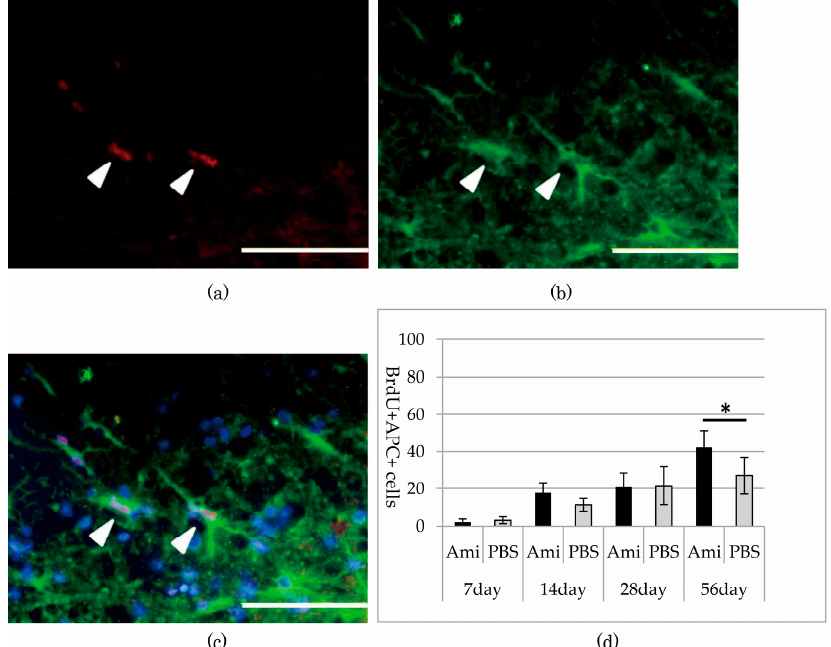
Figure 4. ( a – c ) Double immunostaining of the dorsal funiculus from the amiloride group at day 56 for BrdU (red) and adenomatous polyposis coli (APC) (green) with DAPI nuclear counterstaining (blue). The arrowheads indicate the BrdU- and APC-positive cells (scale bars 50 µm); ( d ) In both the amiloride and PBS groups, the number of BrdU- and APC-positive cells increased after SCI. Significantly more BrdU- and APC-positive cells were observed in the amiloride group than in the PBS group on day 56. The asterisk indicates significant difference between the amiloride and PBS groups with a Mann–Whitney U test (* p < 0.05, n = 5 per group, error bars are standard deviations).